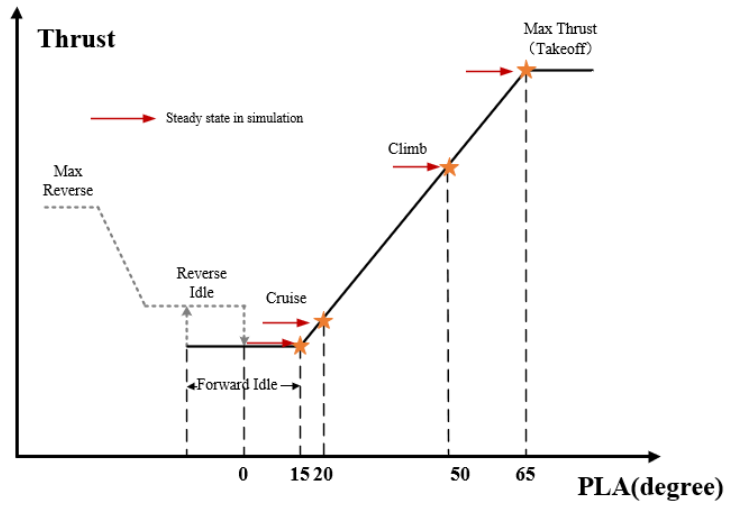
Figure 5. PLA command Interpolation